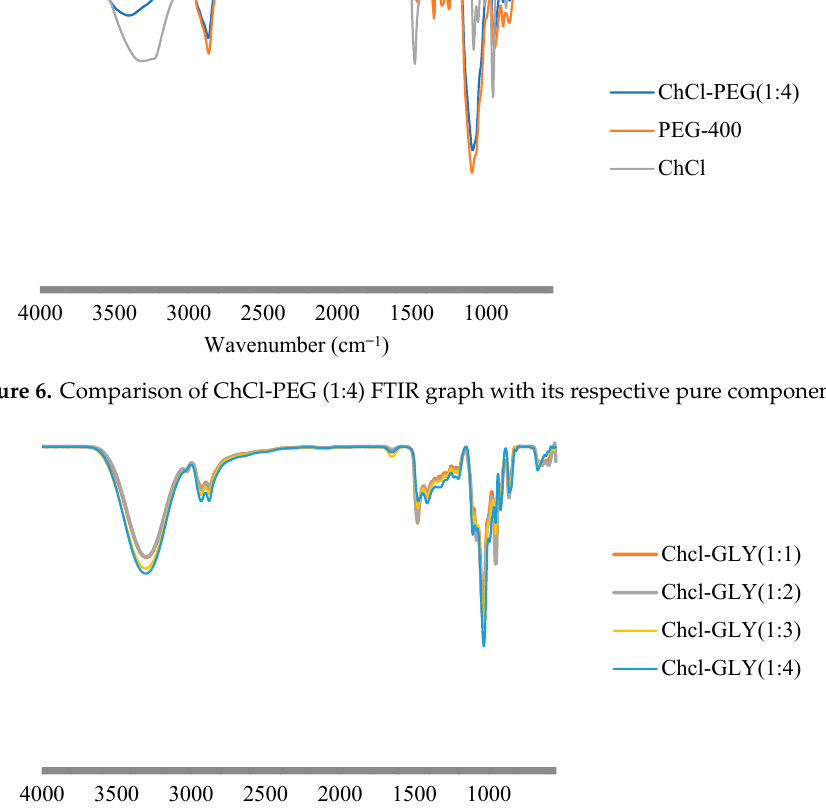
Figure 7. FTIR graph of ChCl-GLY with mole ratio of 1:1 to 1:4 (HBA:HBD).